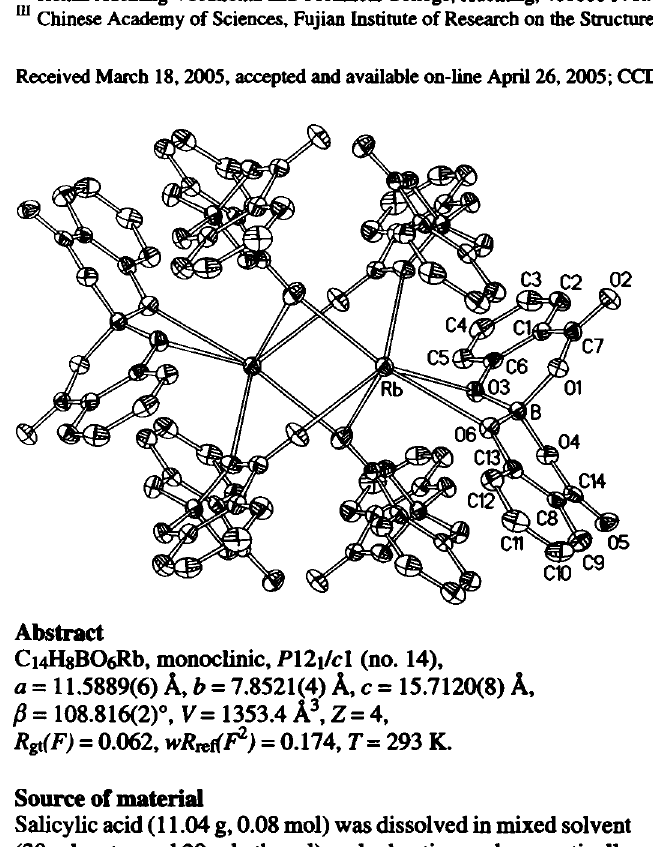
Table 1. Data collection and handling.